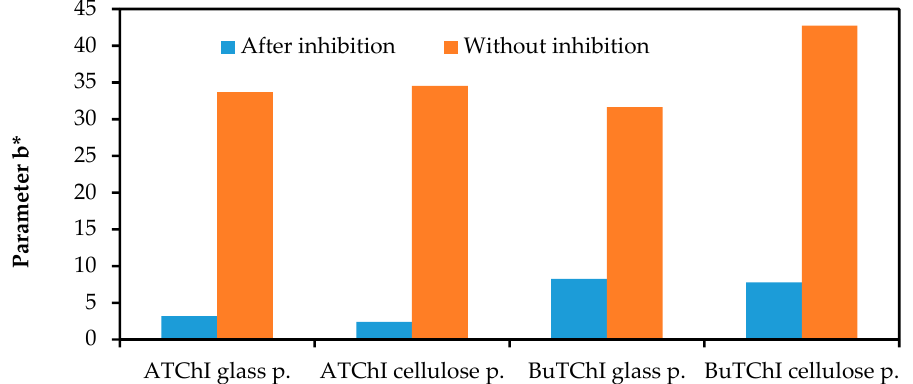
Figure 10. The functions of the biosensor after testing the thermal stability in a dryer in a container at 60 °C, with inhibition by physostigmine solution (concentration 100 µg/mL, incubation period 2 min, measured after 2 min).